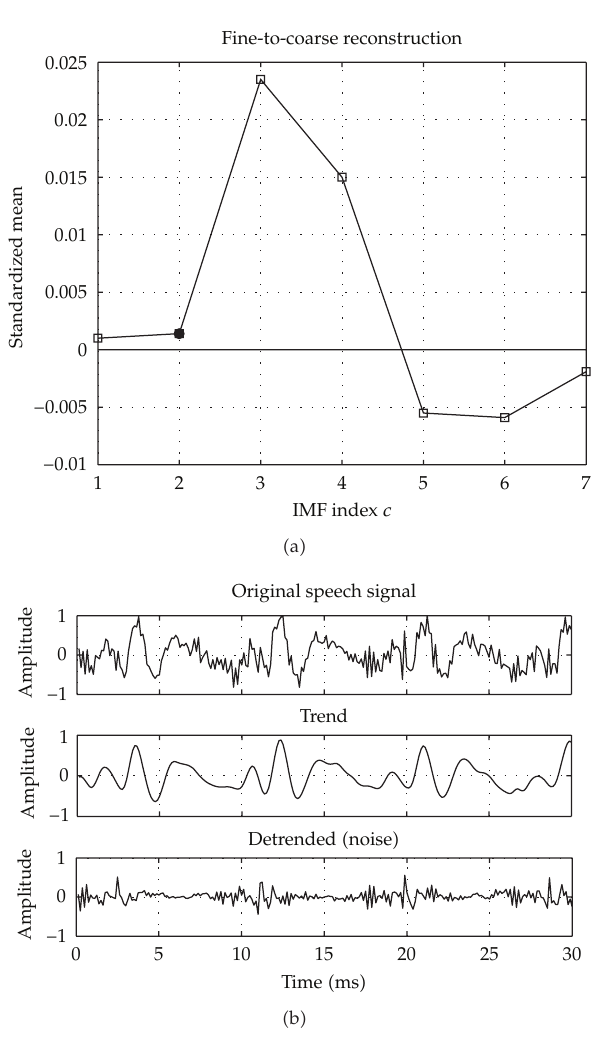
Figure 6: Trend detection noisy speech signal. (cid:2) a (cid:3) Standardized empirical mean of the fine-to-coarse EMD reconstruction, evidencing C (cid:8) 2 as the change point; (cid:2) b (cid:3) top: original signal, middle: estimated trend obtained from the partial reconstruction with IMFs 3 to 7 (cid:9) the residual, bottom: noise (cid:2) detrended (cid:3) signal obtained from the partial reconstruction with IMFs 1 to